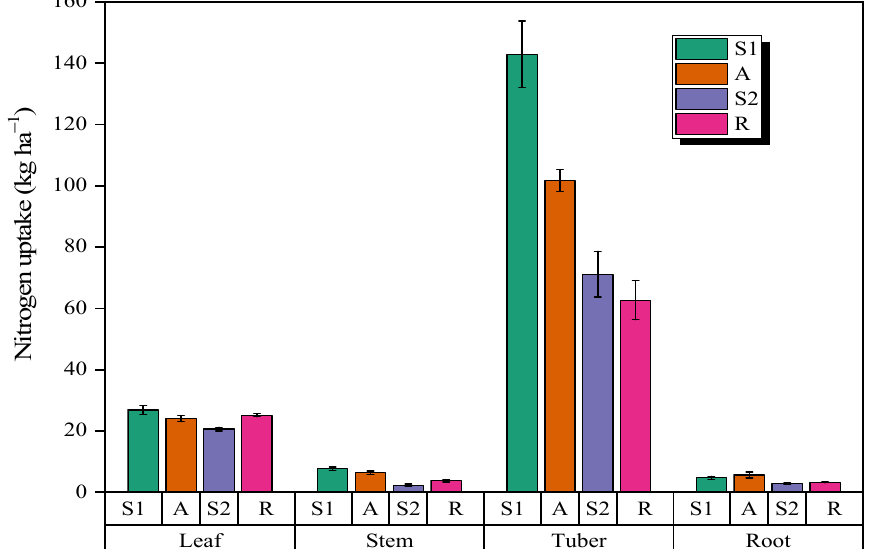
uted to higher yield.